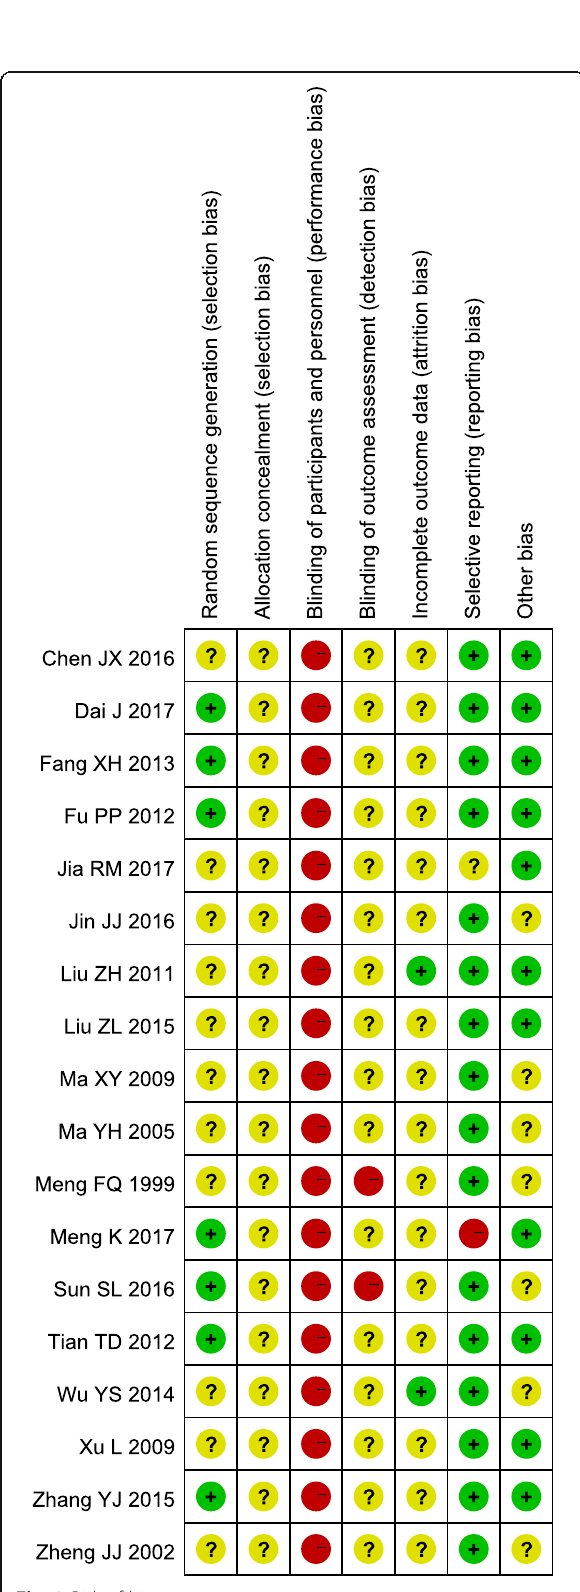
Fig. 2 Risk of bias